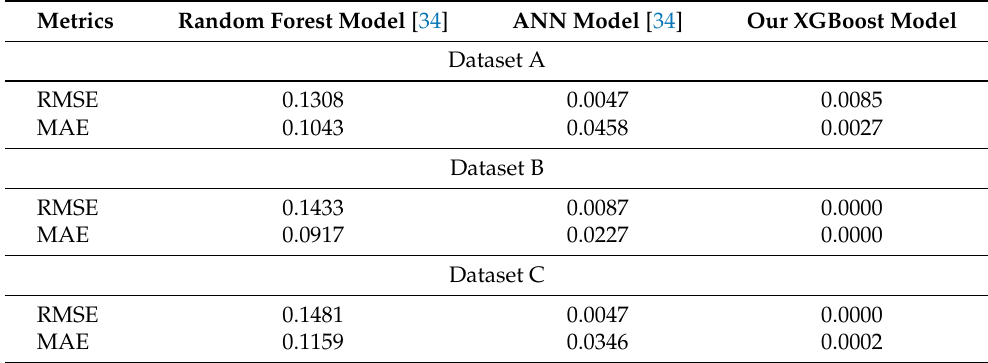
Table 8. Overall performance comparison with the benchmark